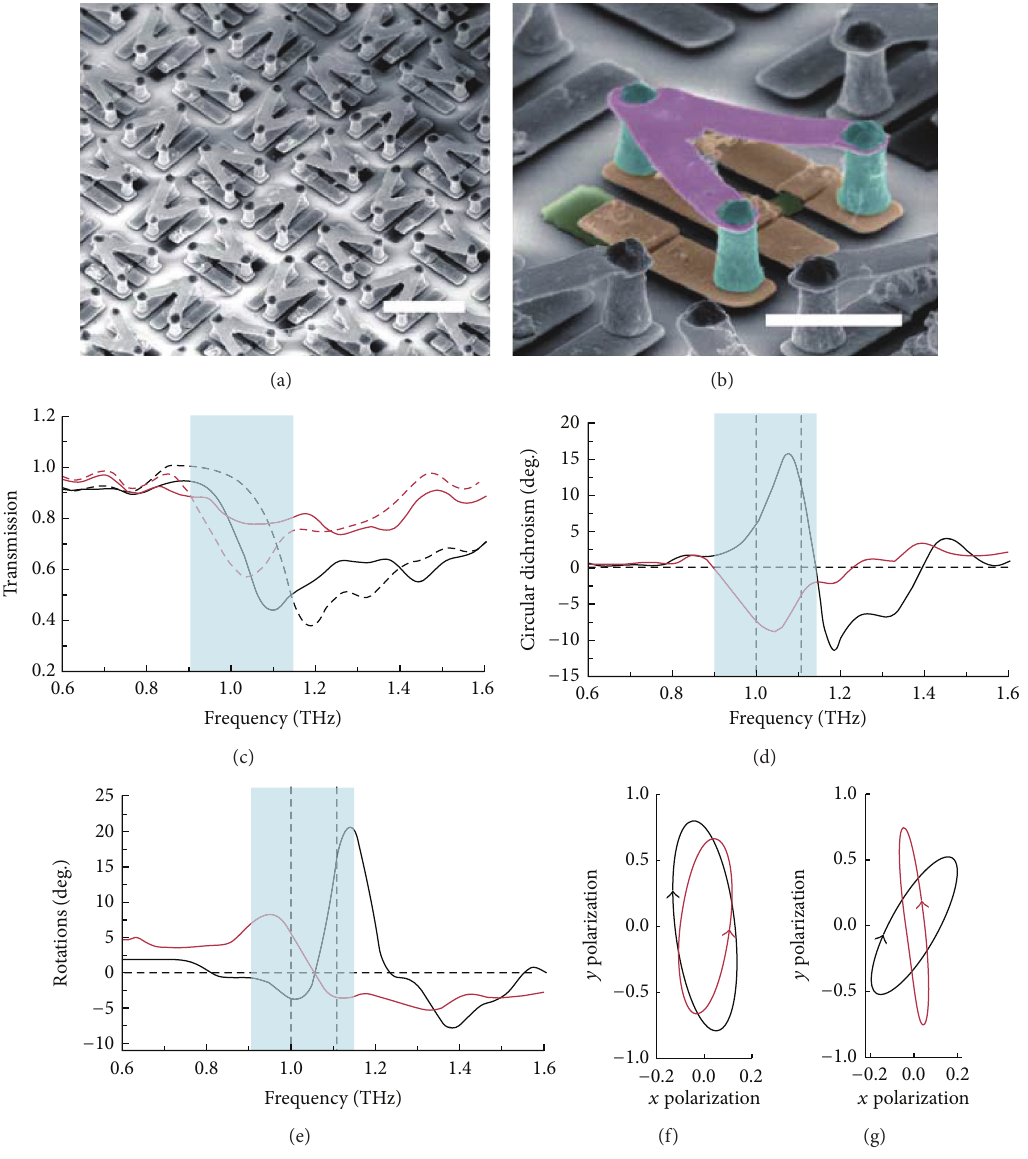
Figure 41: Geometry and the results of the photoinduced handedness switching metasurface. Figures are reproduced from [164].